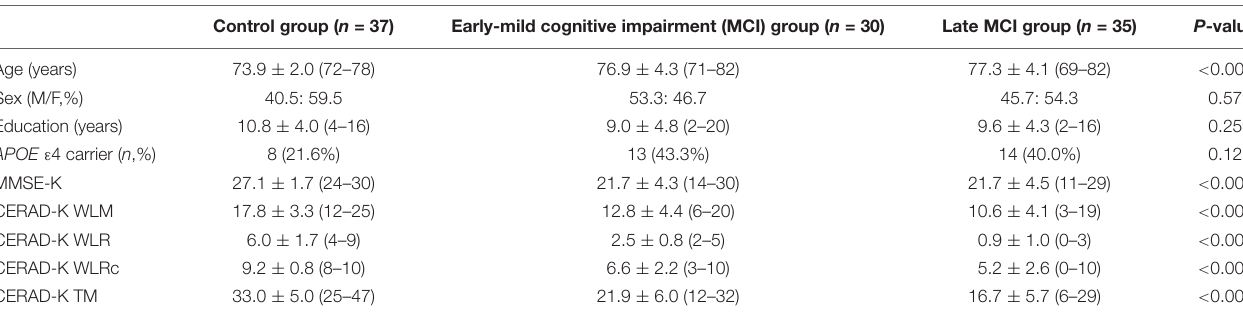
TABLE 1 | Demographic and clinical characteristics of the study